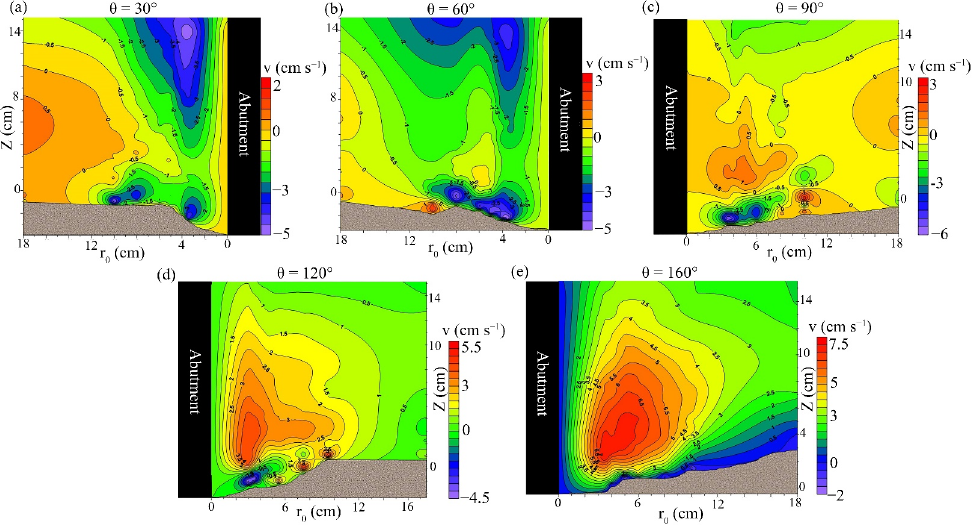
Figure 11. Velocity field in the radial direction ( v , cm/s) for the case of a vegetated bed at different azimuthal sections of θ . Note that the range of the color scale is not equalized for better illustration.